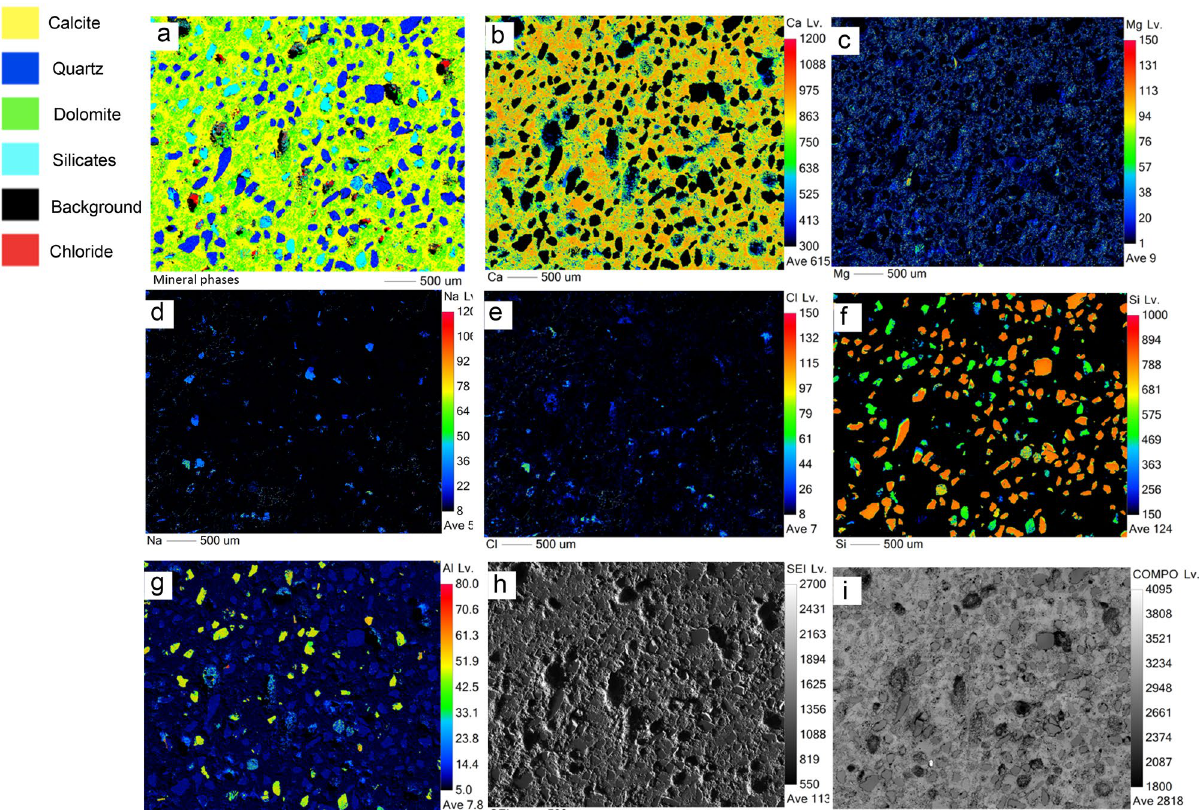
Figure 5. EPMA results of MV1 showing: ( a ) mineralogic maps, elemental maps of ( b ) Ca, ( c ) Mg, ( d ) Na, ( e ) Cl, ( f ) Si, and ( g ) Al, ( h ) secondary electron image, and ( i ) backscattered image. Dolomite microcrystals show a mesh-like structure that possibly indicating dissolution of susceptible dolomite. The absence of fossils suggests dolomitization in the upper tidal flat − 3 resulting from the present is discerned from other phases of CaMg(CO 3 ) 2 from the space group symmetry R ordering reflections of (101), (015), and (021), which are the distinguishable criteria of ordered dolomite 43 . Dolomite in the burrows, MV1, and MV2 matches different dolomite standards varying in stoichiometry and ordering degree. Dolomite stoichiometry ranges from Ca 1.07 Mg 0.93 (CO 3 ) 2 to stoichiometric CaMg(CO 3 ) 2 and the ordering degree ranges from 0.44 to 0.66 calculated from the intensity ratio of (105) and (110) reflections: I (105) / I (110)44 . The attenuation of ordering indicates Ca 2+ ions are occupying Mg 2+ positions and vice versa 43 . The peaks labeled with the letter (C) denote the mineral calcite, and dolomite peaks are labeled with the Miller indi- ces where the ordering reflections are in bold (Figs. 3, 4). The major peaks for quartz correspond to 2 θ = 20.81 and 26.6, for halite correspond to 2 θ = 31.68 and 45.41, and minor silicates clay mineral correspond to 2 θ = 27.9. The details of mineral abundance in the rocks are analysed from EPMA data (Table 1) by calculating the normalized area to percentage from the compositional mineral phase maps. Figure 5 (MV1), Fig. 6 (MV2), and Fig. 7 (MV3) display the compositional mineral phase maps in panel ‘a’ and the elemental density maps of Ca, Mg, Na, Cl, Si, and Al in panels ‘b, c, d, e, f, and g’, respectively. The distribution of mineral phases is mapped